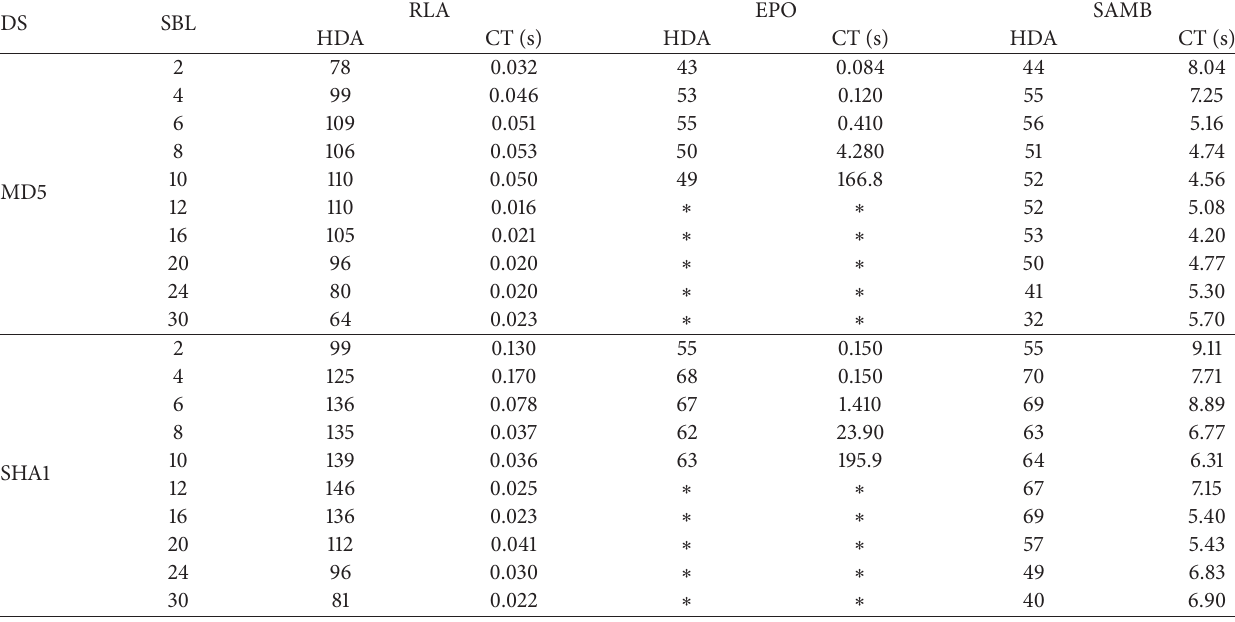
Table 1: HDAs and CTs (PentiumIV at 2.2 GHz) with the automated tool for the sum as combinational logic ( ∗ resources exceeded). DS